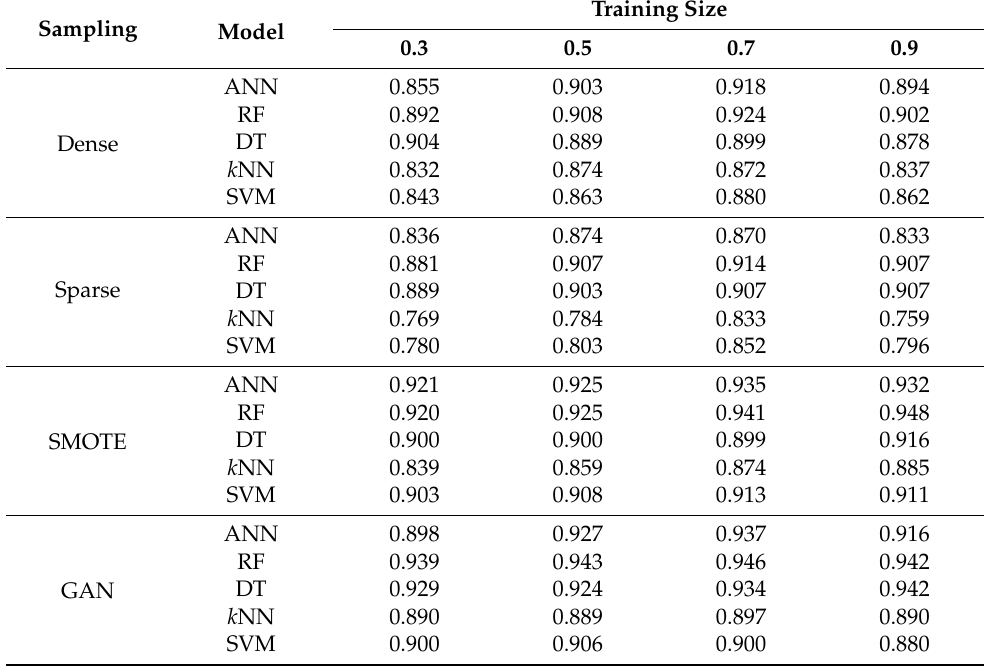
Table A5. Assessment of the models with different sampling methods based on OA.